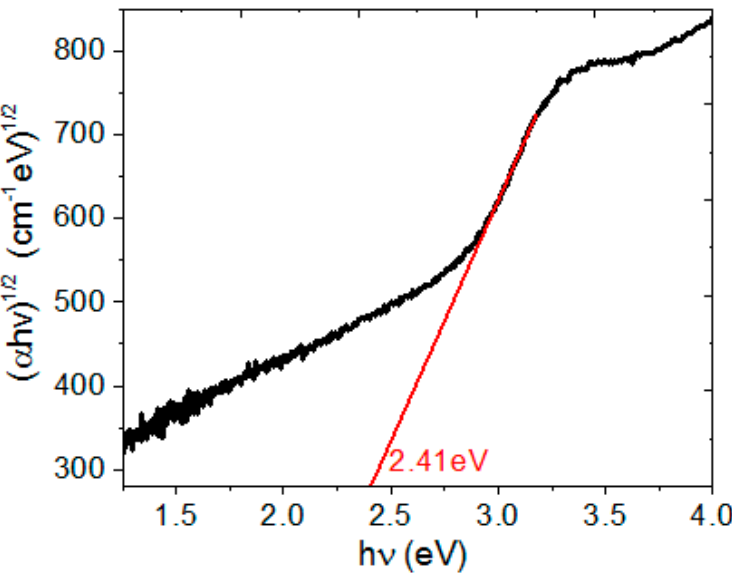
Figure 7. Plot of ( α h ν ) 1/2 as a function of the photon energy ( h ν ) of the ZnQ 2 -TCNQ film. Table 3. The first 15 singlet–singlet transitions allowed. E T is the energy of the electronic transition, and f the oscillator strength.